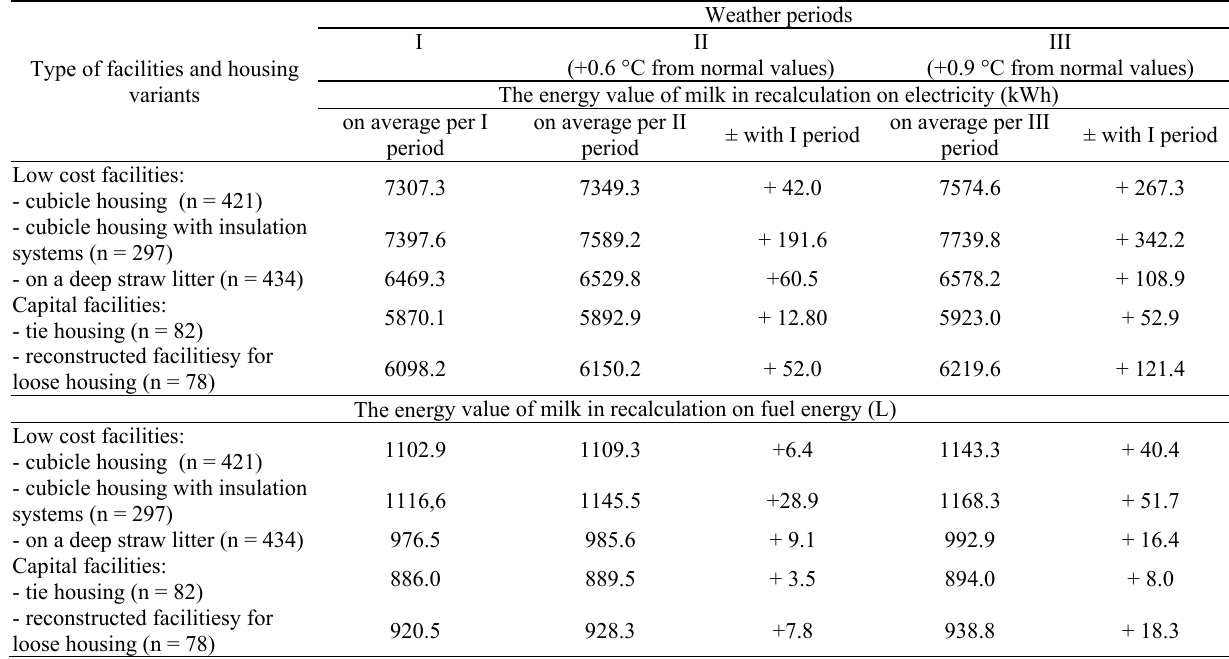
The energy value of milk in recalculation on fuel energy (L) and electricity (kWh) per 1